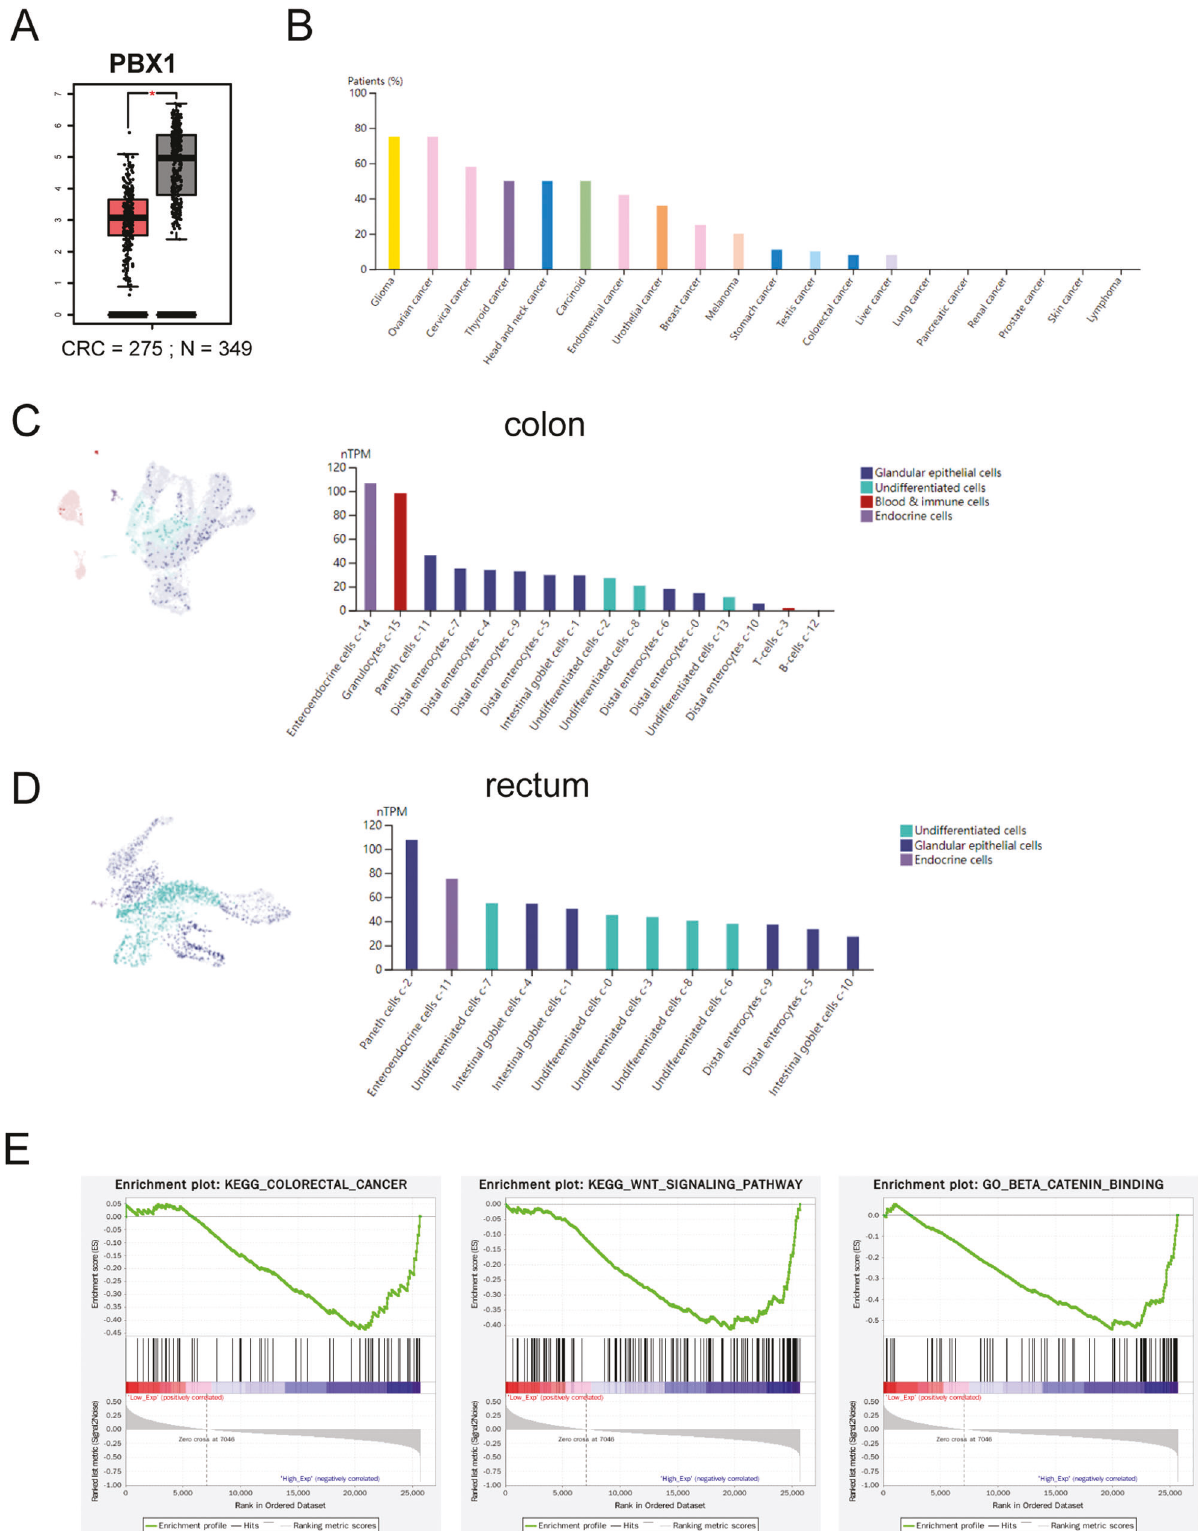
Fig. 1 PBX1 expression was suppressed in CRC. A The PBX1 RNA levels were lower in CRC samples compared to normal tissues, according to the TCGA and GTEx databases. B The expression levels of PBX1 in different cancer types from the THPA database. Both colon and rectal cancer had low levels. C , D scRNA-seq showed the PBX1 levels in diverse cell types of the colon and rectum. Undifferentiated cells had lower PBX1 expression compared to matured cell types. E GSEA analysis indicated that colorectal cancer, Wnt, and beta-catenin pathway were inhibited in PBX1 high